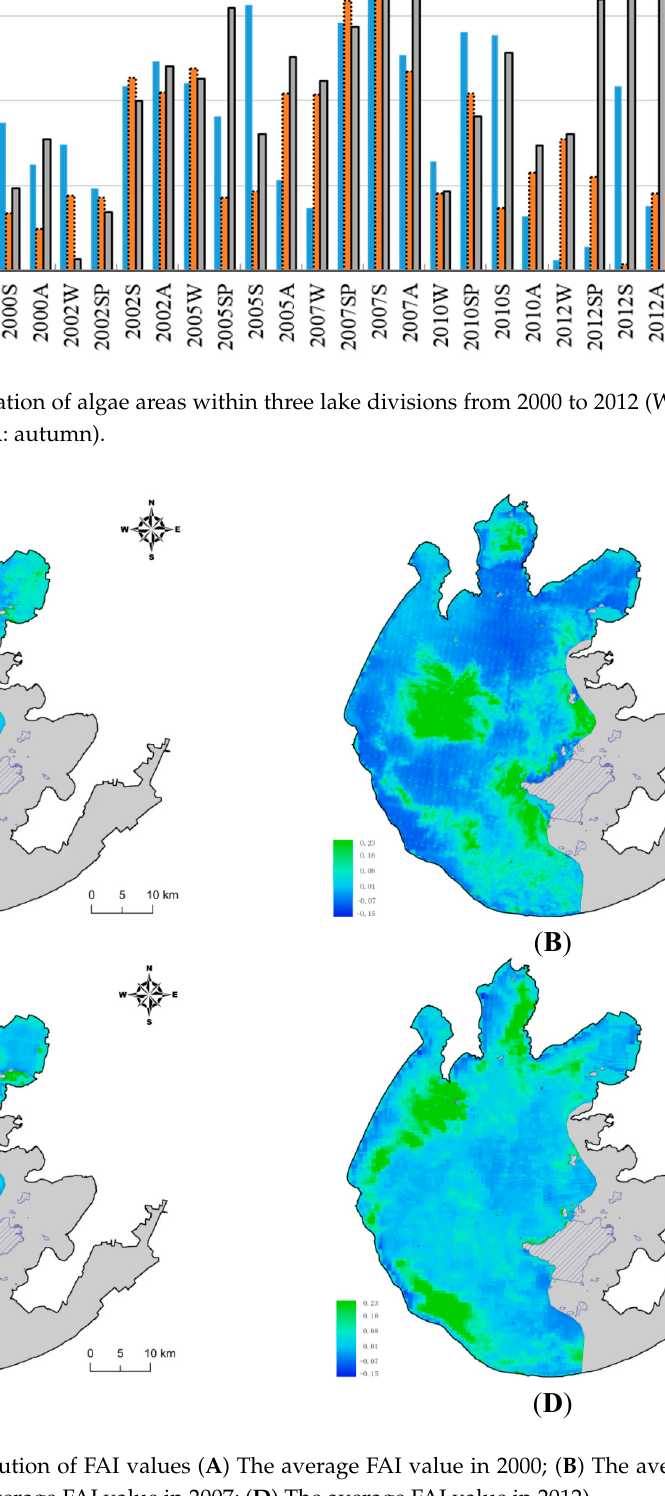
Figure 4. Spatial distribution of FAI values ( A ) The average FAI value in 2000; ( B ) The average FAI value in 2005; ( C ) The average FAI value in 2007; ( D ) The average FAI value in 2012).